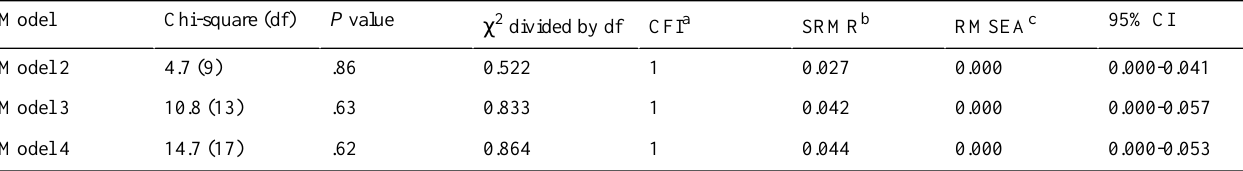
Table 5. Fit statistics of mediation models 2, 3, and